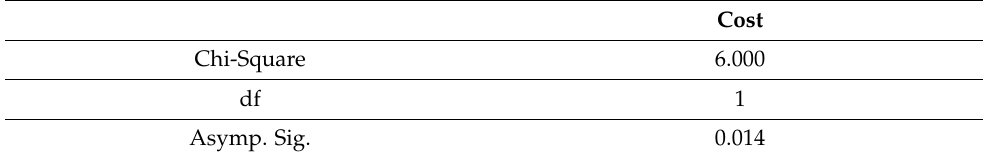
Table 6. Test statistics a,b for differences between the two groups.